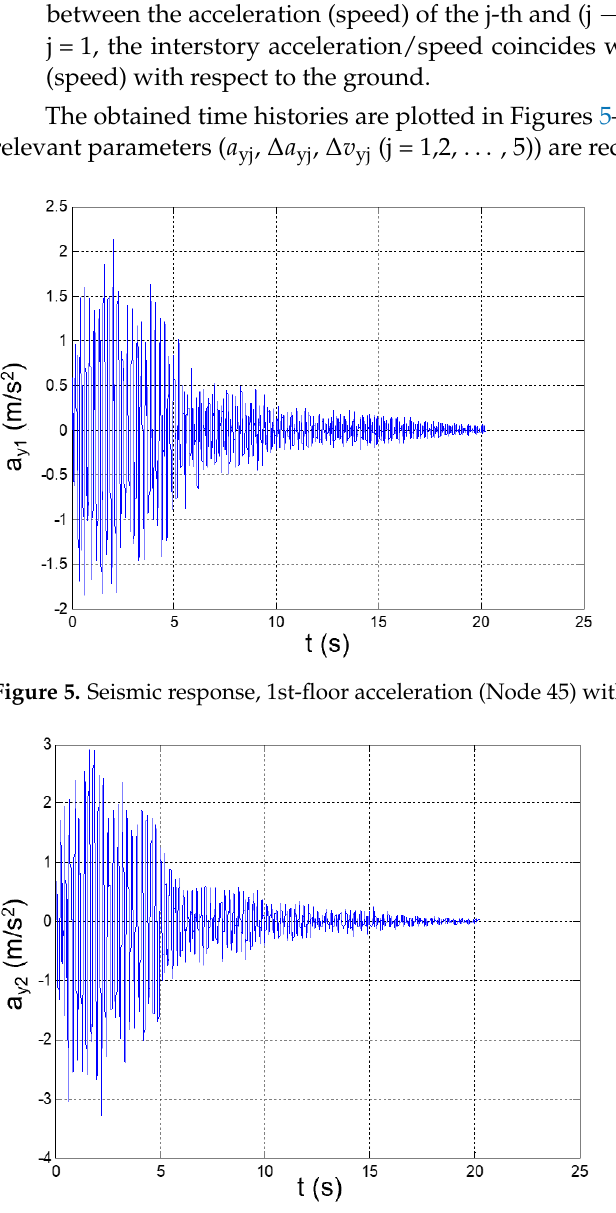
Figure 6. Seismic response, 2nd-floor acceleration (Node 46) with respect to the ground.